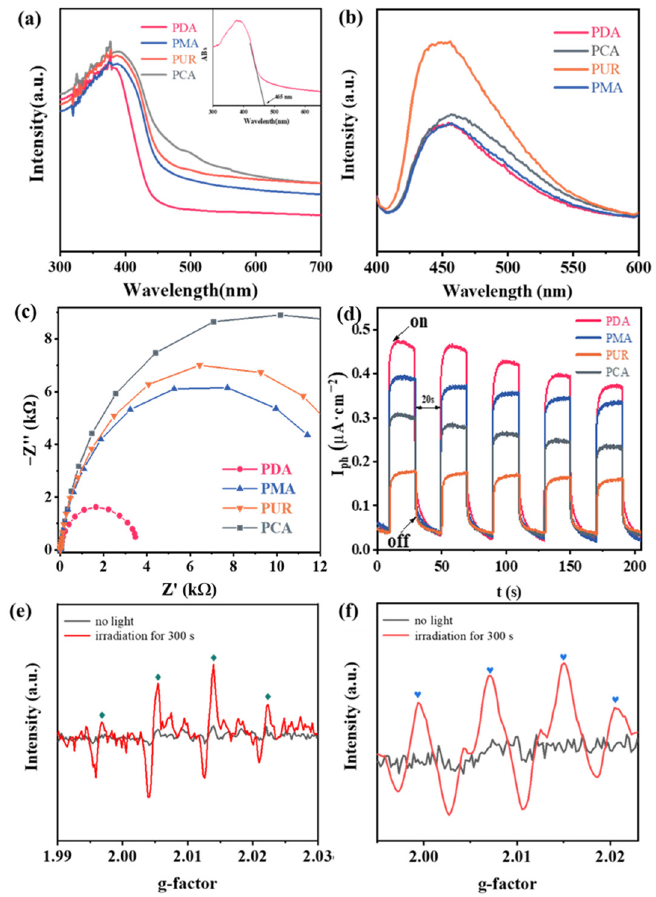
Figure 5. ( a ) DRS patterns, ( b ) photoluminescence spectra, ( c ) EIS Nyquist plots, ( d ) Photocurrent responses of PDA, PCA, PUR and PMA samples, EPR spectra of PDA for the detection of ( e ) DMPO– · OH, ( f ) DMPO– · O 2 −